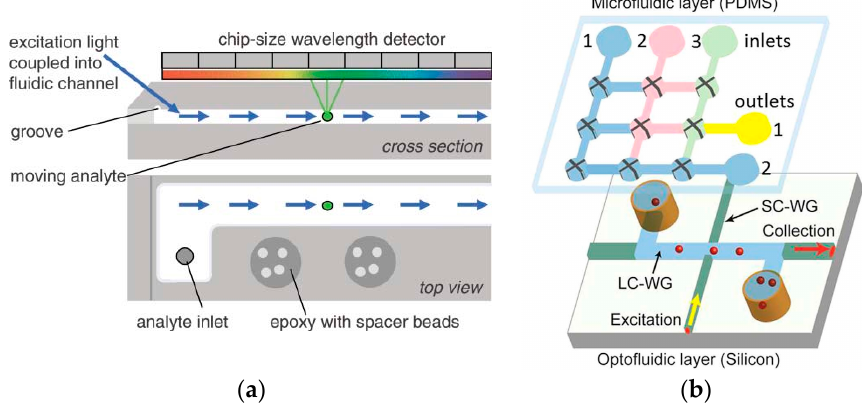
Figure 4. ( a ) The cross section and top view of the fluidic channel. The excitation light is coupled into the fluidic channel and the imager records the fluorescence emission of the analytes while they move along the channel. Reproduced from [63] with permission from The Royal Society of Chemistry. ( b ) The prototype of the ARROW chip for sample preparation and single nucleic acid measurement. Reproduced from [64] with permission from The Creative Commons Attribution 4.0 International License.